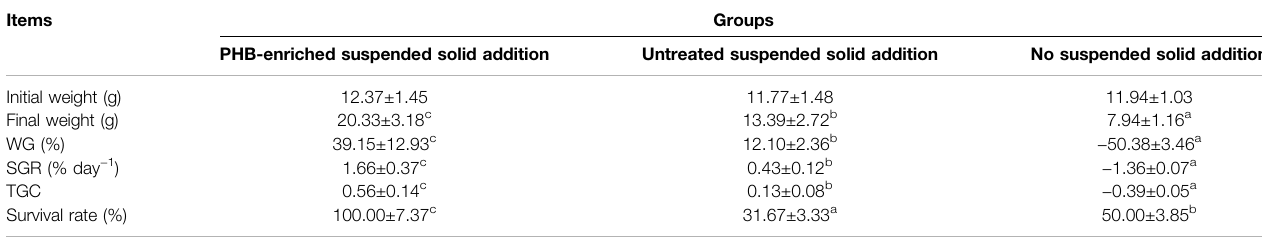
TABLE 3 | Growth performance of gibel carp ( Carassius auratus gibelio ) at day 30 after fed with PHB-enriched suspended solids. Items